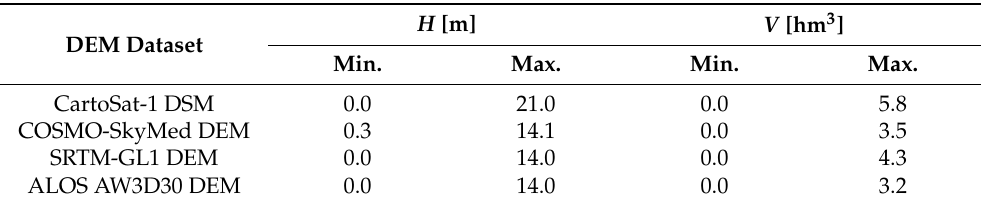
Table 2. Comparison of tell height ( H ) and volume ( V ) ranges between the analyzed DEM datasets. Notation: Min., minimum; Max.